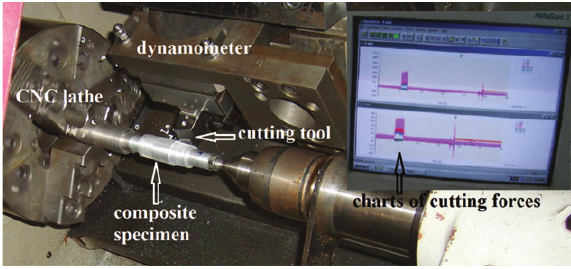
Figure 2 Test setup for the machining tests (JOHNFORD TC-35 CNC Lathe, Taiwan).